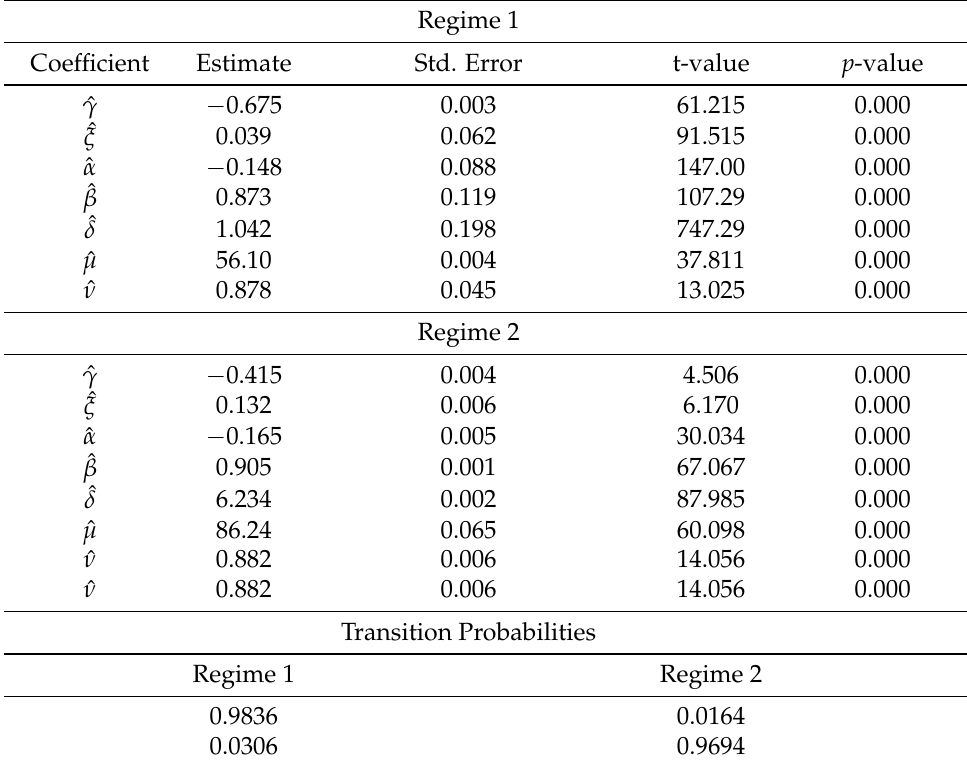
Table 2. Naive Bayesian Estimates of